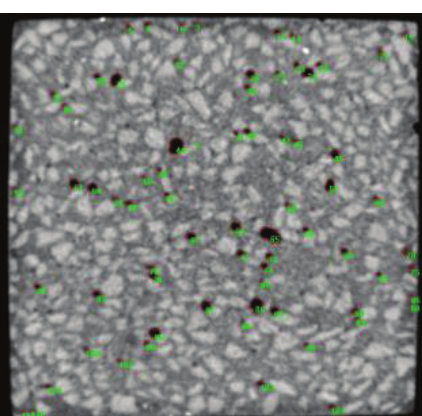
Figure 5: Compositional analysis of EDS spectra for concrete samples.